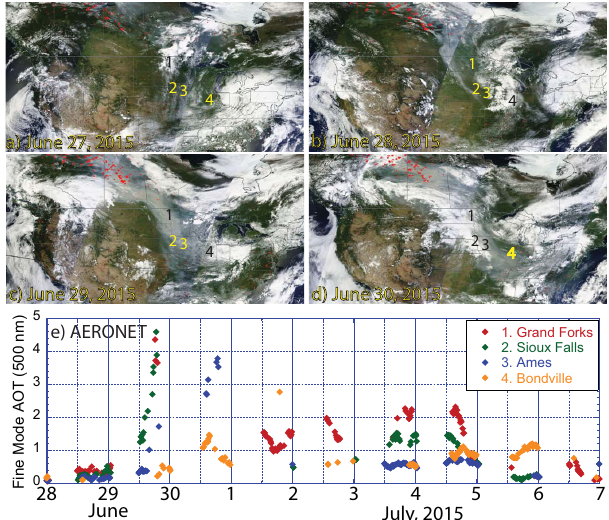
Figure 2. Overview of the 29 June burning event. (a–d) MODIS Terra RGB with daily combined MODIS active fire hotspot detec- tions for 27–30 June. (e) Time series of AERONET fine-mode τ 500 , sites marked 1–4 indicated on panels (a–d)